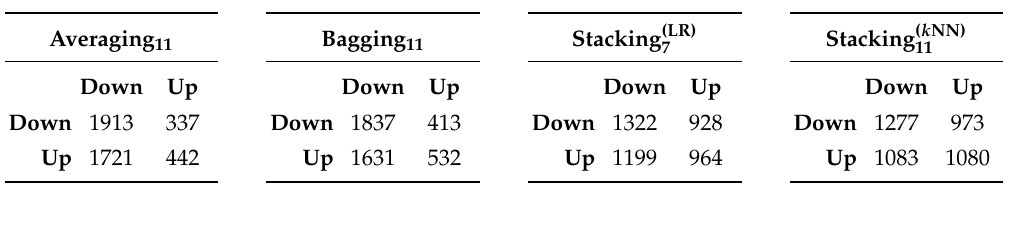
and Stacking ( k NN) using 7 11